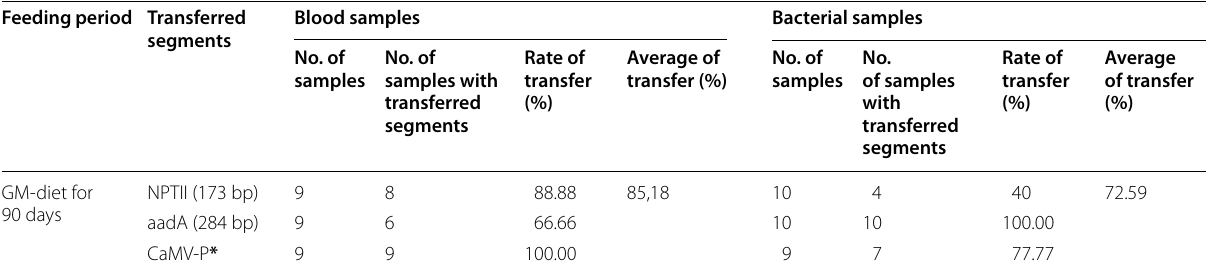
CaMV-P * : Two segments from the CaMV promoter were used; Cf3-Cr4 (123 bp) was amplified in blood and P-35S (195 bp) was amplified in Bacteria